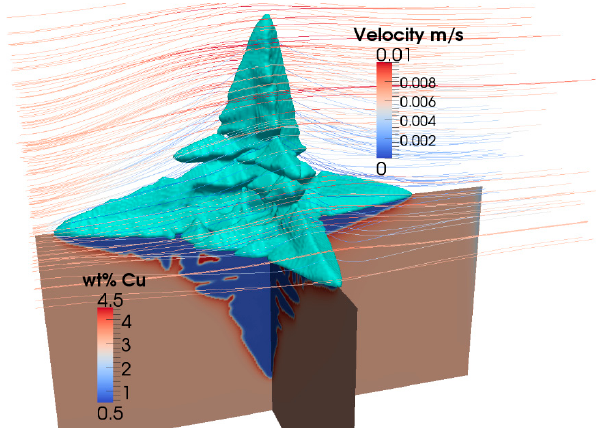
Figure 7. Snapshot of a 3D solutal dendrite growing under melt convection. The top part depicts the 3D dendrite morphology with the streamlines showing the melt velocity around it. The bottom part shows the solute distribution in two perpendicular cross sections.